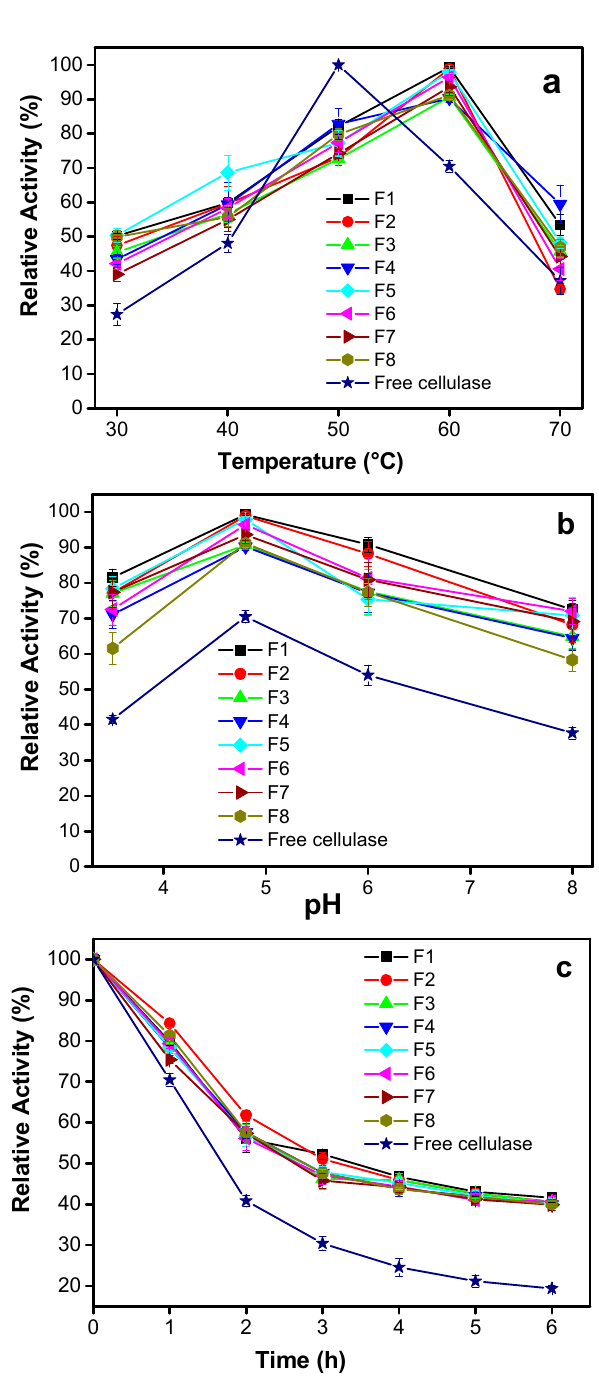
Figure 2. Relative activity of cellulase encapsulated in alginate beads prepared by using 2% (w/v) alginate formulations (F1–F8, Table 1) in comparison to that of the free enzyme, showing the degradation of carboxymethylcellulose at: ( a ) different temperatures after 1 h at pH 4.8; ( b ) different pH after 1 h at 60 °C; ( c ) different times at pH 4.8 and 60 °C.